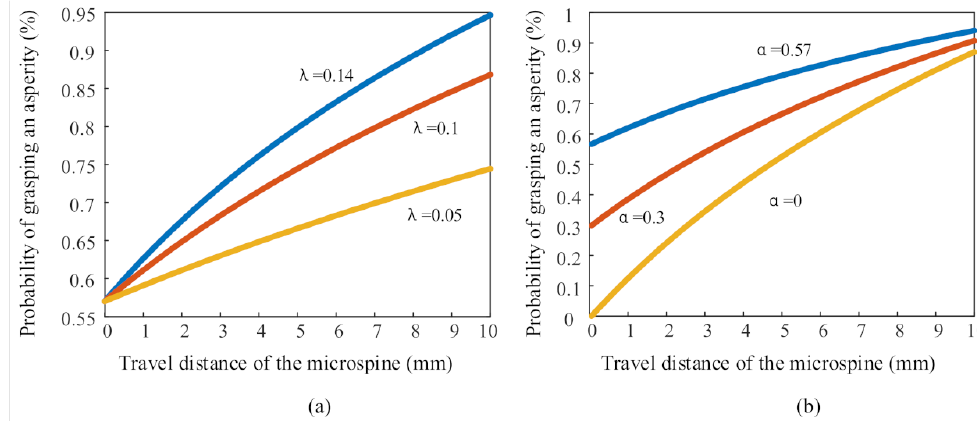
Figure 4. Influence of surface properties on grasping probability.